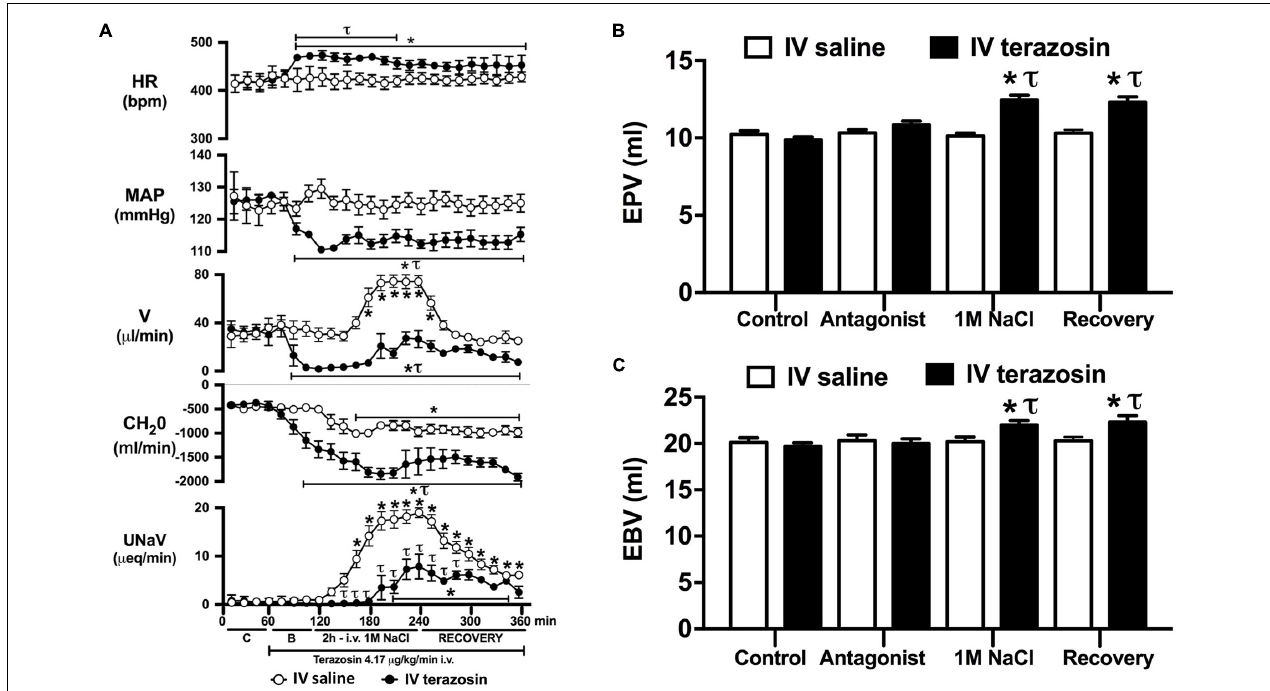
FIGURE 4 | Effect of acute i.v. terazosin-mediated α 1 -drenoceptor antagonism on the cardiovascular and renal responses to an acute 1M NaCl infusion (A) Cardiovascular and renal responses, (B) Estimated blood volume (ml), and (C) Estimated plasma volume (ml) during a 1-h control isotonic saline infusion (20 µ l/min), a 1-h baseline terazosin infusion (4.17 µ g kg − 1 min − 1 in isotonic saline; 20 µ l/min), a 2-h terazosin and 1M NaCl infusion (20 µ l/min) and a 2-h recovery period of terazosin in isotonic saline infusion (20 µ l/min) in intact conscious male Sprague Dawley rats, HR = heart rate (bpm), MAP = mean arterial pressure (mmHg), V = urinary flow rate ( µ L/min), CH 2 O = free water clearance, UNaV = urinary sodium excretion ( µ eq/min), C = control saline infusion, B = Baseline during terazosin infusion. Data are presented as mean ± SEM, N = 6/group. * p < 0.05 vs. group baseline value in last 15-min of the control saline infusion. τ p < 0.05 vs. respective isotonic saline group infusion